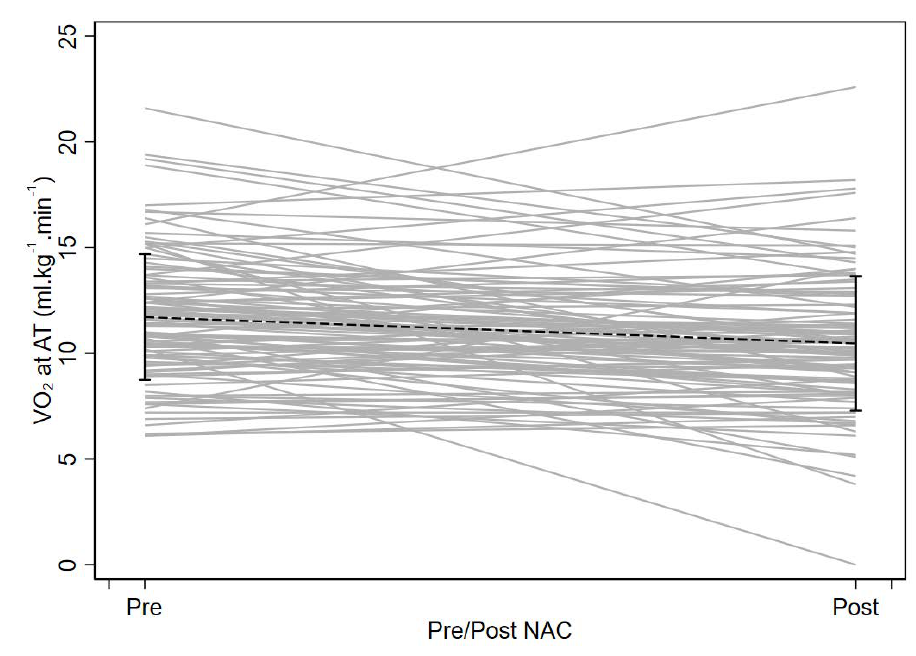
Figure 2. A ladder plot of oxygen uptake at anaerobic threshold (VO chemoradiotherapy (NAC/CRT).